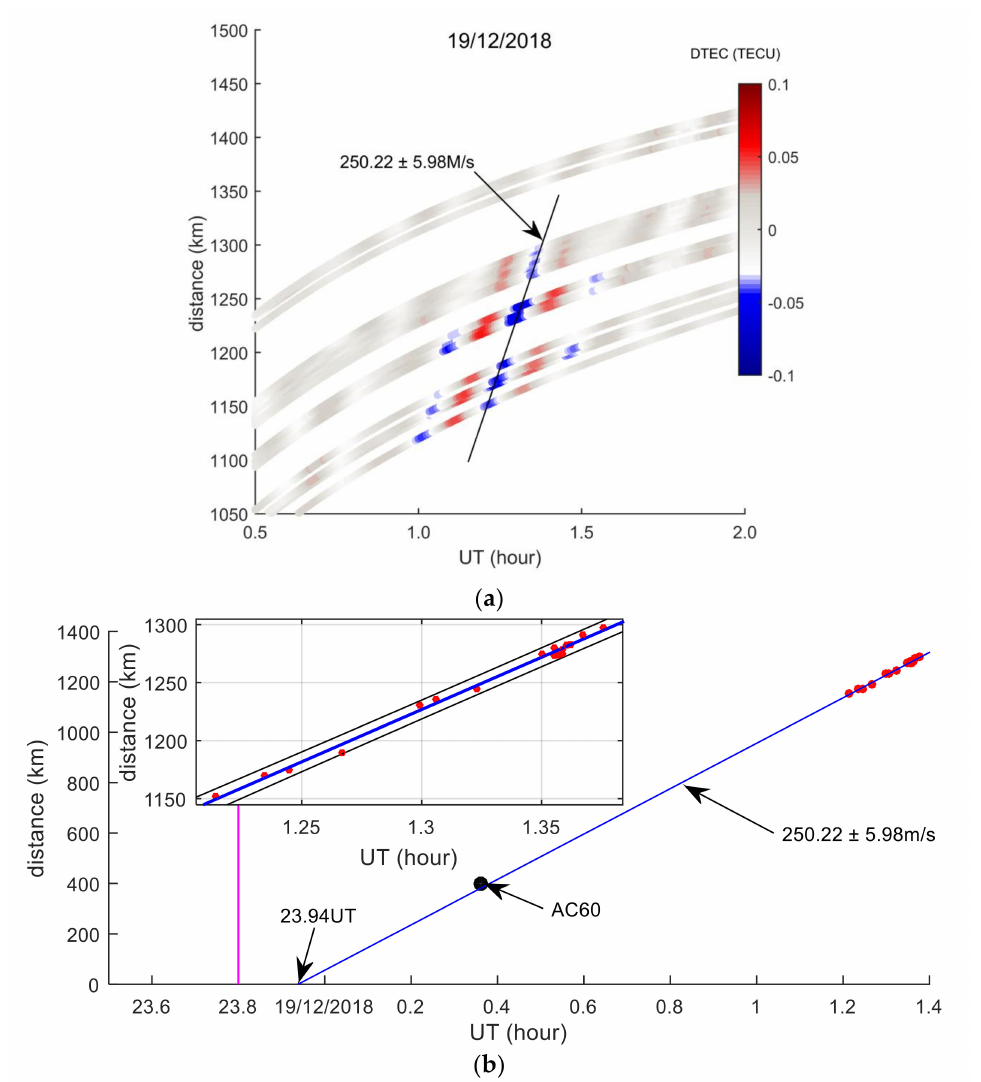
Figure 13. TEC disturbances distance-time graph estimated by 20 GPS stations and PRN05 satellite on 19th. The abscissa represents time, and the ordinate represents the spherical distances between IPPs and the meteor explosion point. The color in ( a ) represents the TEC disturbance time series ( DTEC ( t )). The slope of the line indicates the velocity of TID propagation in ( b ). The rectangular frame is an enlarged view of the TID, and the black dotted line indicates the 95% confidence interval. The black dot is the TID of the AC60 station, and the purple line indicates the time of the meteor